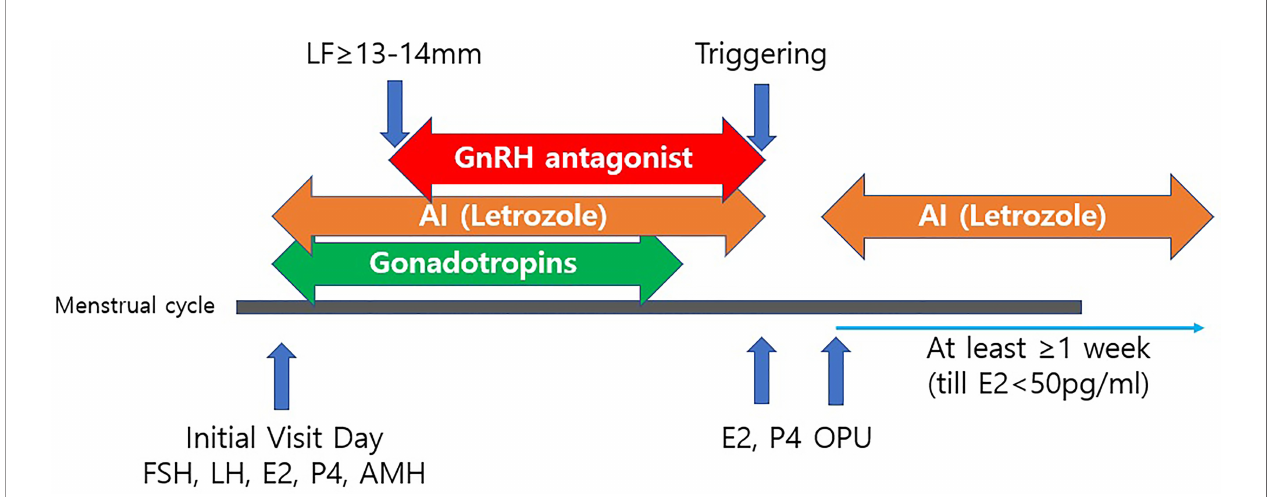
FIGURE 1 | A controlled ovarian stimulation schedule for patients with breast cancer. LF, leading follicle; AI, Aromatase Inhibitor (Letrozole 5mg/day); Triggering with either rhCG, GnRH agonist or dual triggering; OPU, Ovum Pick-Up; rhCG, recombinant human chorionic gonadotropin; GnRH, Gonadotropin releasing hormone; FSH, follicle-stimulating hormone; LH, Luteinizing hormone; E2, Estradiol; P4, Progesterone; AMH, Anti-Müllerian